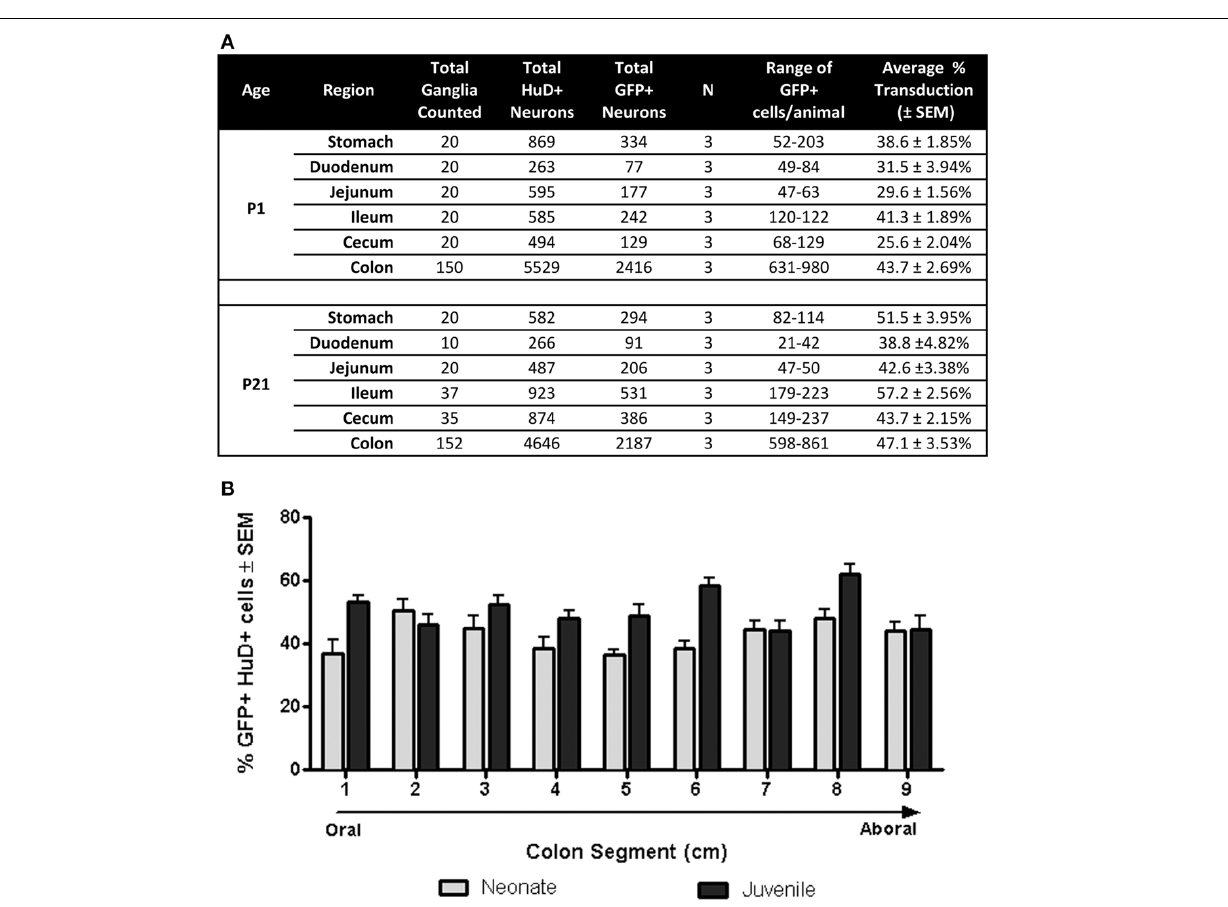
neonatally injected mice. Transduction ranged from ∼ 42 to 57% in juvenile injected mice. (B) Quantification of GFP myenteric neurons across the oral to aboral length of the colon revealed no transduction differences between proximal and distal colon segments in neonatal and juvenile injected